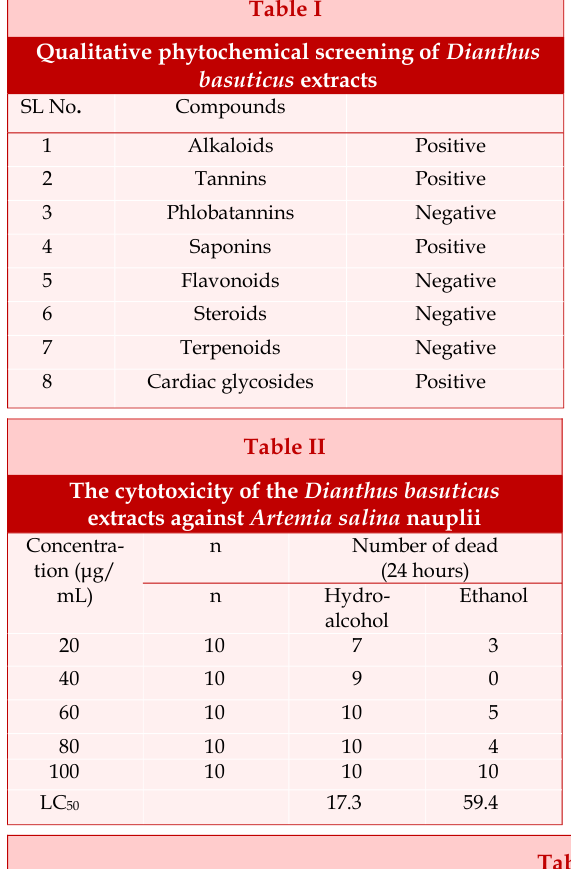
The cytotoxicity of the Dianthus basuticus extracts against Artemia salina nauplii